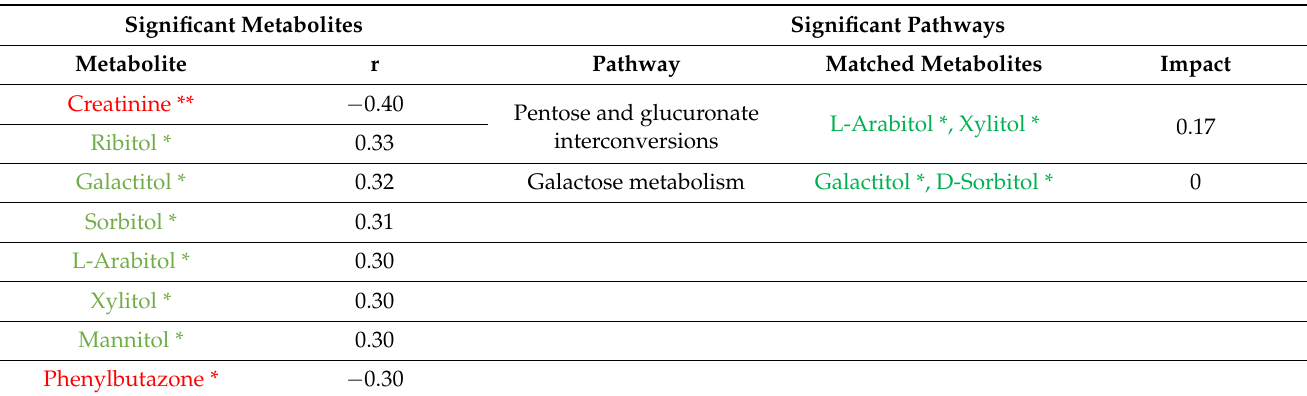
Figure 5. Metabolite-metabolite interaction network for significant metabolites that correlate to autism symptoms. Size of the node indicates importance in the network. The interaction analysis highlights with citric acid cycle metabolites such citric acid and carbon dioxide as well as glucogenic amino acids, such as L-serine, glycine, and L-glutamine, highlighting the role of energy metabolism and the mitochondria specifically. Table 7. Metabolites and their pathways which correlate with autism symptoms. Table 8. Metabolites and their pathways which correlate with language